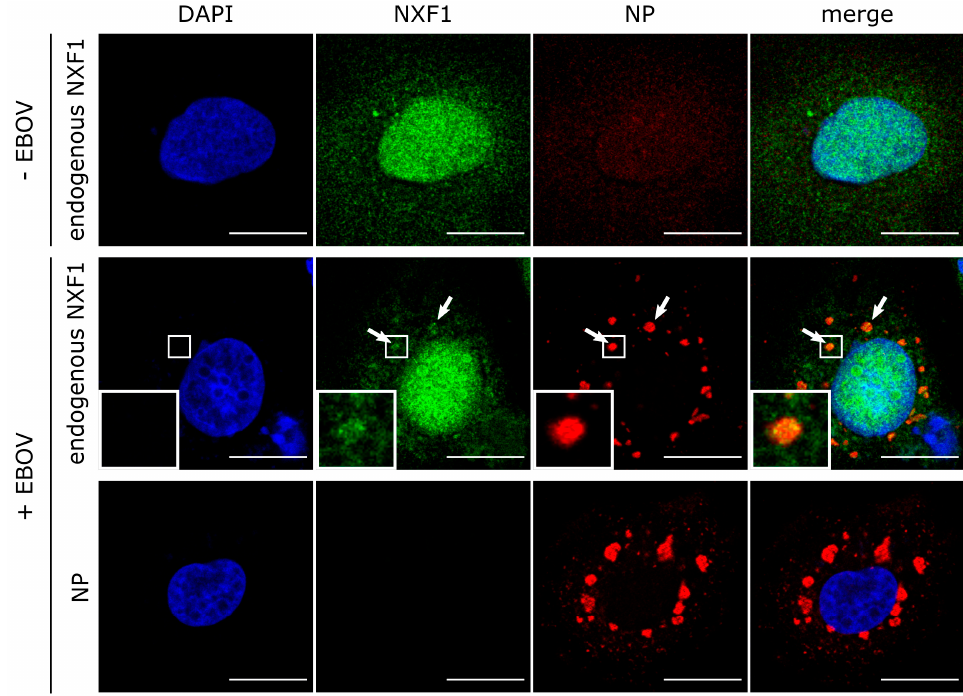
Figure 6. Recruitment of endogenous NXF1 into EBOV inclusion bodies. Huh7 cells were infected with rgEBOV. Sixteen hours p.i., cells were fixed with 10% formalin and permeabilized with Triton X-100. NXF1 (shown in green) was detected with anti-NXF1 antibodies and NP (shown in red) with anti-NP antibodies. Nuclei were stained with DAPI (shown in blue), and cells were visualized by confocal laser scanning microscopy. Scale bars indicate 20 µ m. Arrows point out colocalization, and insets show magnifications of indicated areas.